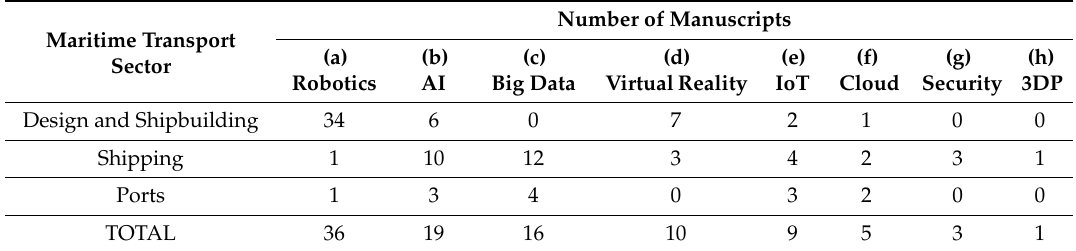
Table 2. Number of studies per digital domain and maritime transport